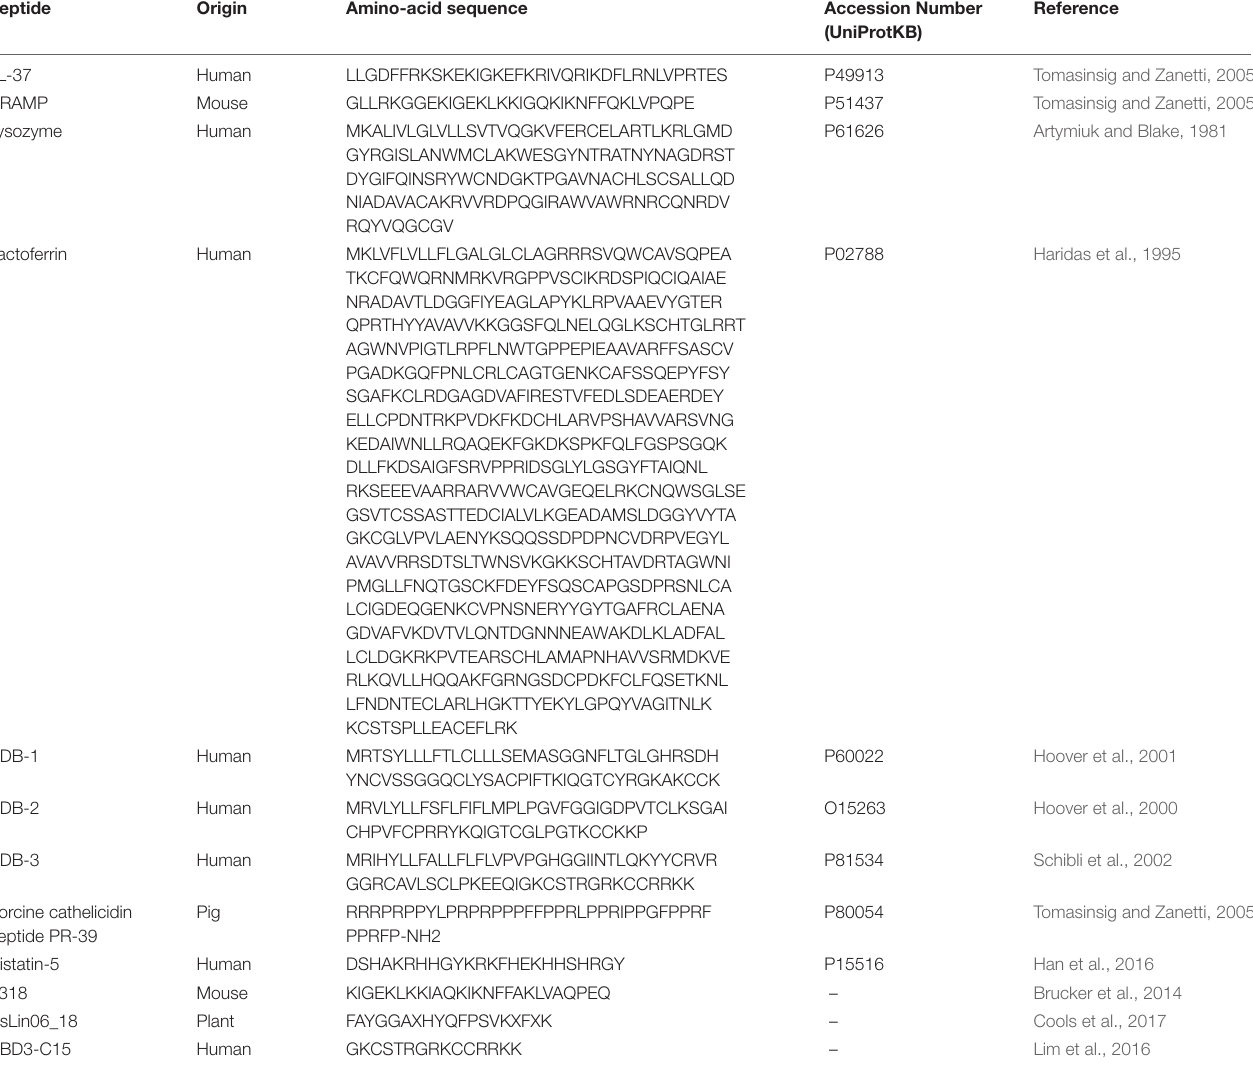
TABLE 3 | Predicted amino-acid sequences (single-letter code) of antimicrobial peptides obtained from Protein Data Bank (RCSB-PDB) or from literature reference.